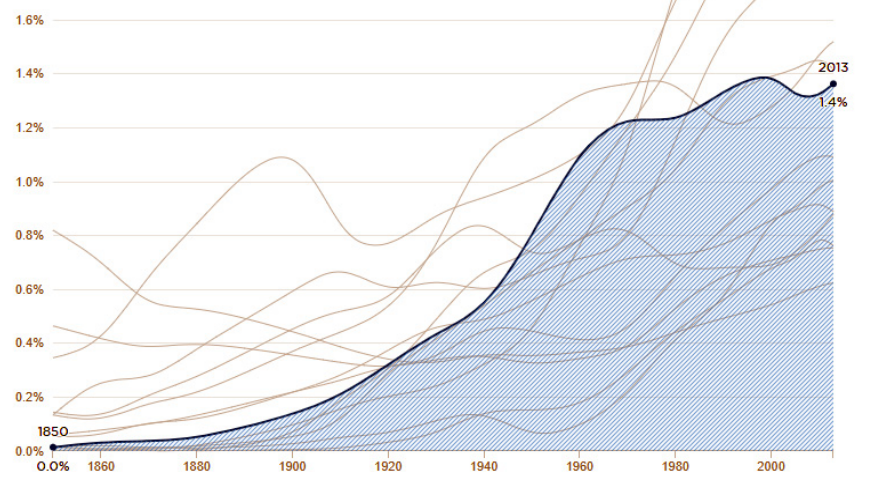
Figure 6. Demand for engineers